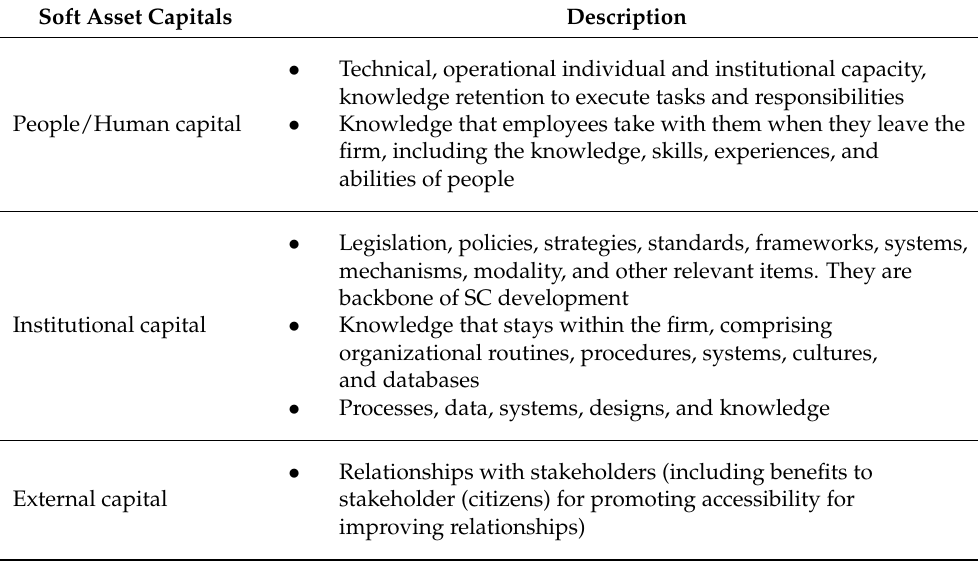
Table 1. Soft asset